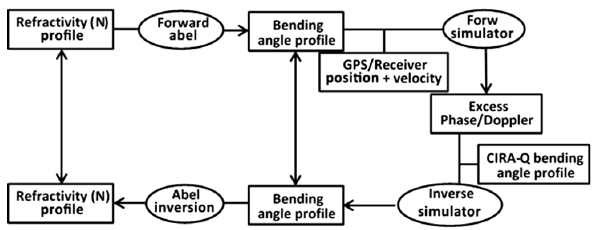
Figure 2. End-to-end simulation system for airborne RO data pro- cessing. (Note: derivation of bending from refractivity in forward Abel does not need the occultation geometry information but only the receiver height and refractivity at the